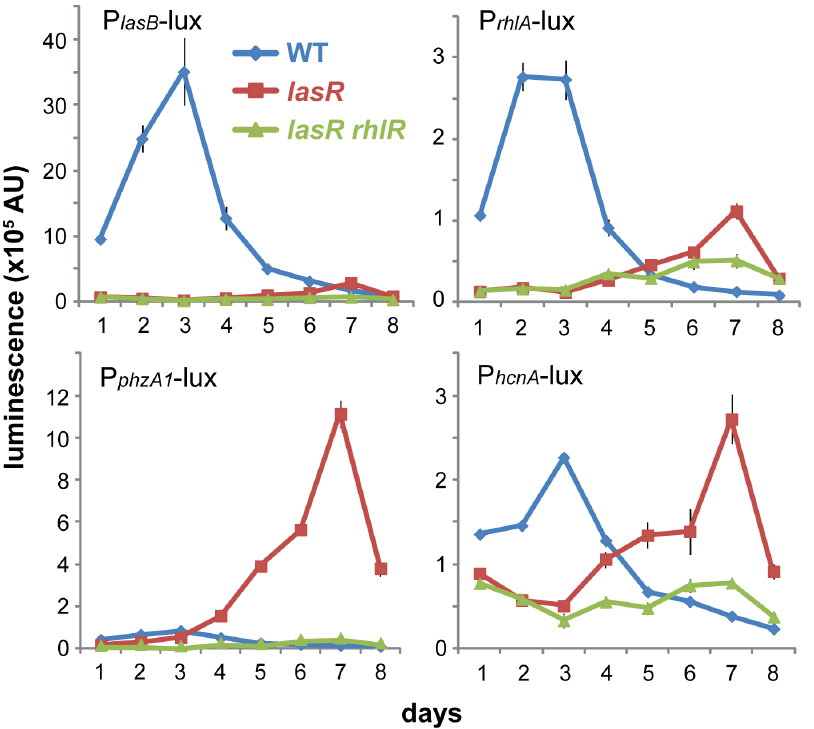
Figure 2. Wild-type and lasR mutant cells display distinct virulence gene expression patterns in stationary-phase culture. Gene expression was measured using chromosomally integrated lux reporters in the listed strain backgrounds. Plots show the mean 6 standard deviation of 3 biological replicates each composed of 3 technical replicates.